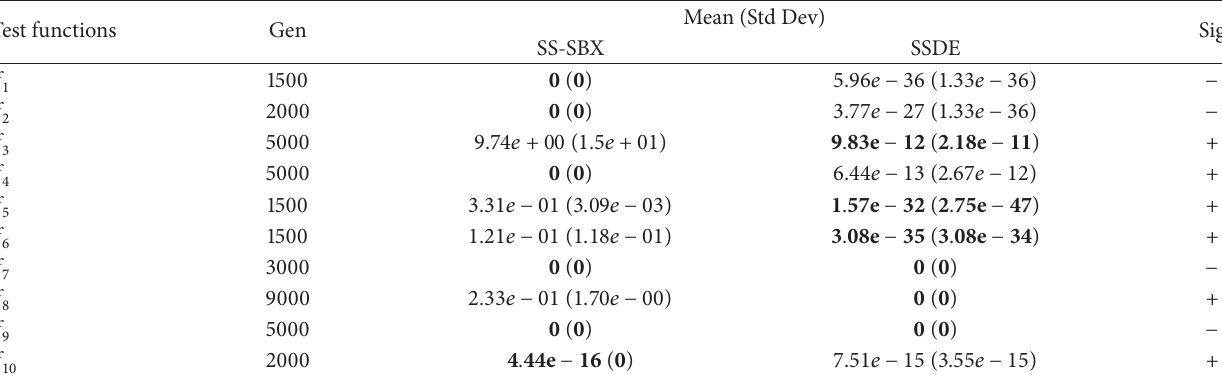
Table 3: Comparison results between SS-SBX and